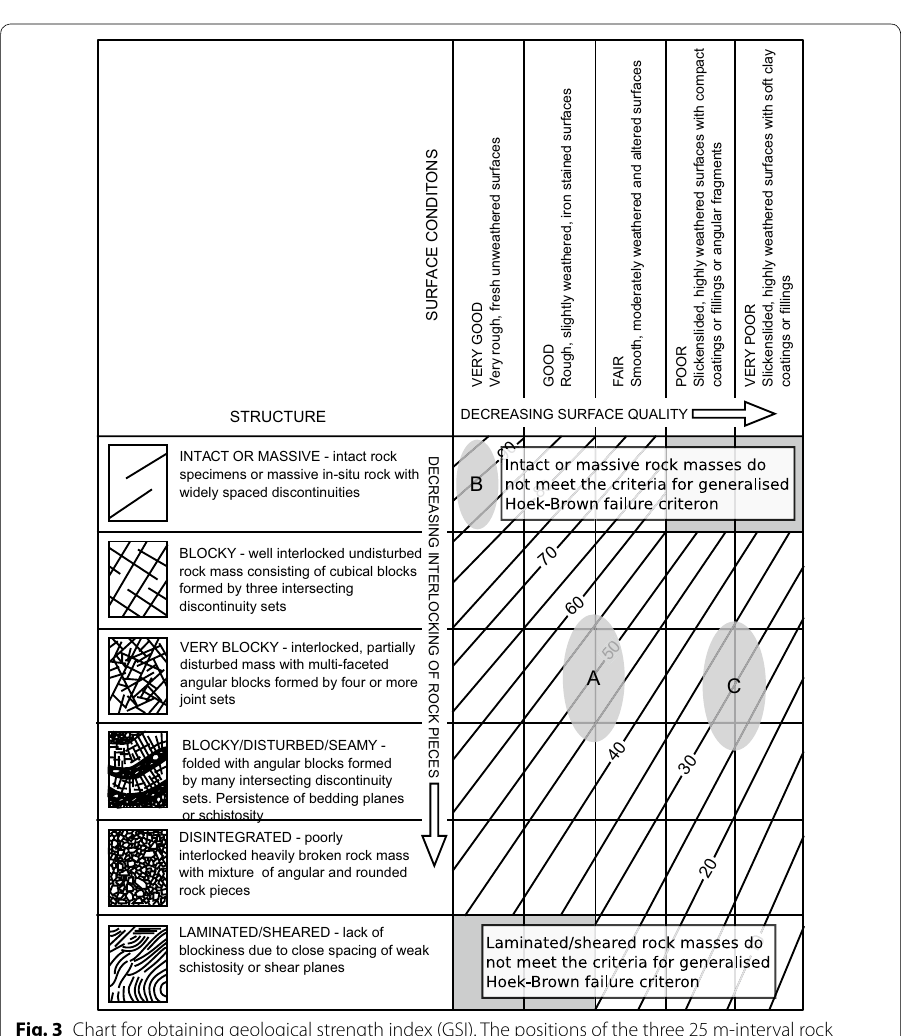
Fig. 3 Chart for obtaining geological strength index (GSI). The positions of the three 25 m-interval rock masses from Fig. 6 are shown on the chart. Note that the highest and lowest category should not be used for the generalised Hoek–Brown failure criterion (Modified from Marinos et al.